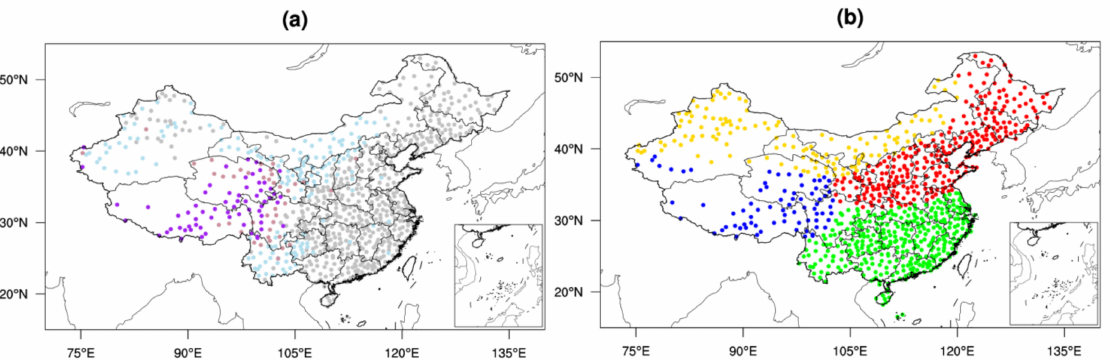
Figure 1. Spatial distribution of observed stations with different elevations ( a ) and regions ( b ). Elevations ( a ) are divided into elevation <1000 m (gray), elevation <1000 m and <2000 m (light-blue), elevation <2000 m and <3000 m (pink), and elevation >3000 m (purple). Regions ( b ) are divided into north (red), south (green), northwest (golden), and Tibetan (blue). According to China’s geographical division [32], observed stations are divided into four geographic regions (Figure 1b), including the north region (276 stations, red), south region (348 stations, green), northwest region (136 stations, golden), and Tibetan region (76 stations, blue). The observation stations are densely distributed in north and south China and sparsely distributed in the northwest and Tibetan region.